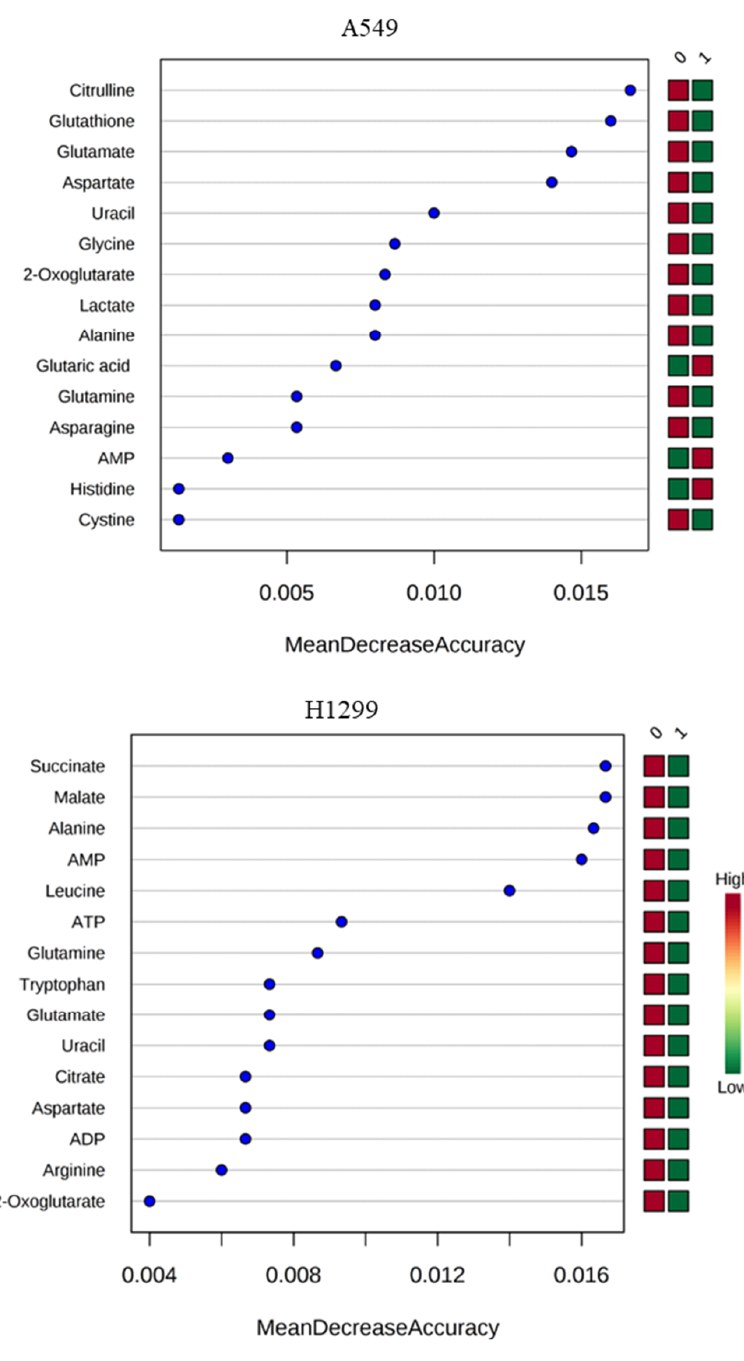
Figure 2. Hierarchical clustering analysis of δT-altered metabolites (Heatmap) and contribution of metabolites in A549 and H1299. The metabolites, quantified with Chenomx software analysis of NMR spectra of A549 and H1299 cells after incubating with or without δT for 72 h, were used to generate the heat map ( A ) using Metaboanalyst software. Each column represents a sample, and each row represents the expression profile of metabolites. Blue color represents a decrease, and red color an increase. The very top row with green color indicates the control samples and red color row indicates the samples with the 30 µM treatment of δT. Random Forest ( B ) showed in bottom graphs identifies the significant features. The features are ranked by the mean decrease in classification accuracy when they are permuted.